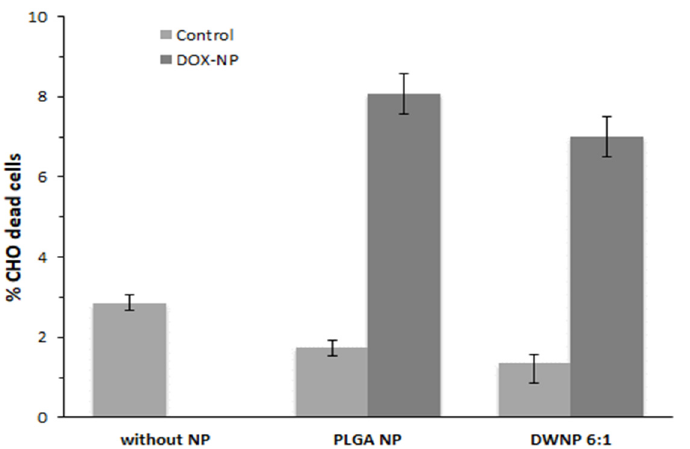
Figure 7. Percentage of dead cells in the presence of 1 mg/mL of unloaded or doxorubicin-loaded PLGA NP and DWNPs 6:1, obtained by flow cytometry, ( n = 3).